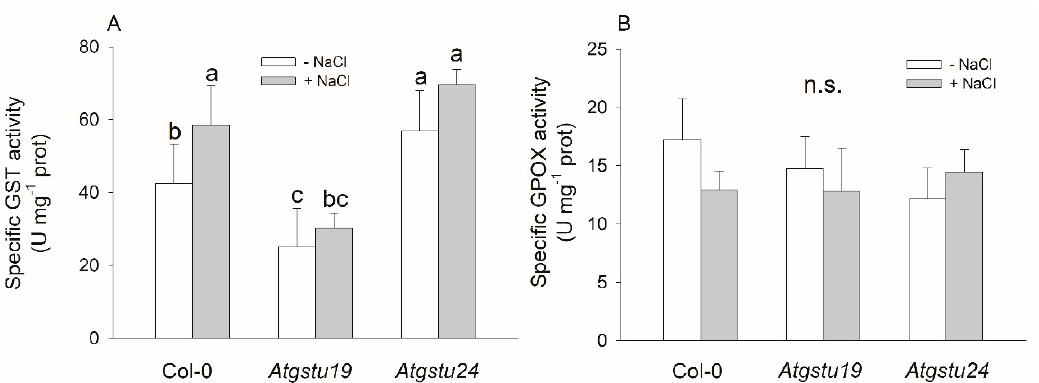
Figure 1. Main glutathione transferase activities of two-week-old wild-type (Col-0) and GSTU mutant ( Atgstu19 and Atgstu24 ) Arabidopsis plants treated with 150 mM NaCl for 48 h. ( A ) Glutathione transferase (GST) activity, ( B ) glutathione peroxidase (GPOX) activity of seedlings. Means ± SD denoted by di ff erent letters indicate a significant di ff erence between the treatments at a p < 0.05 level according to Duncan’s